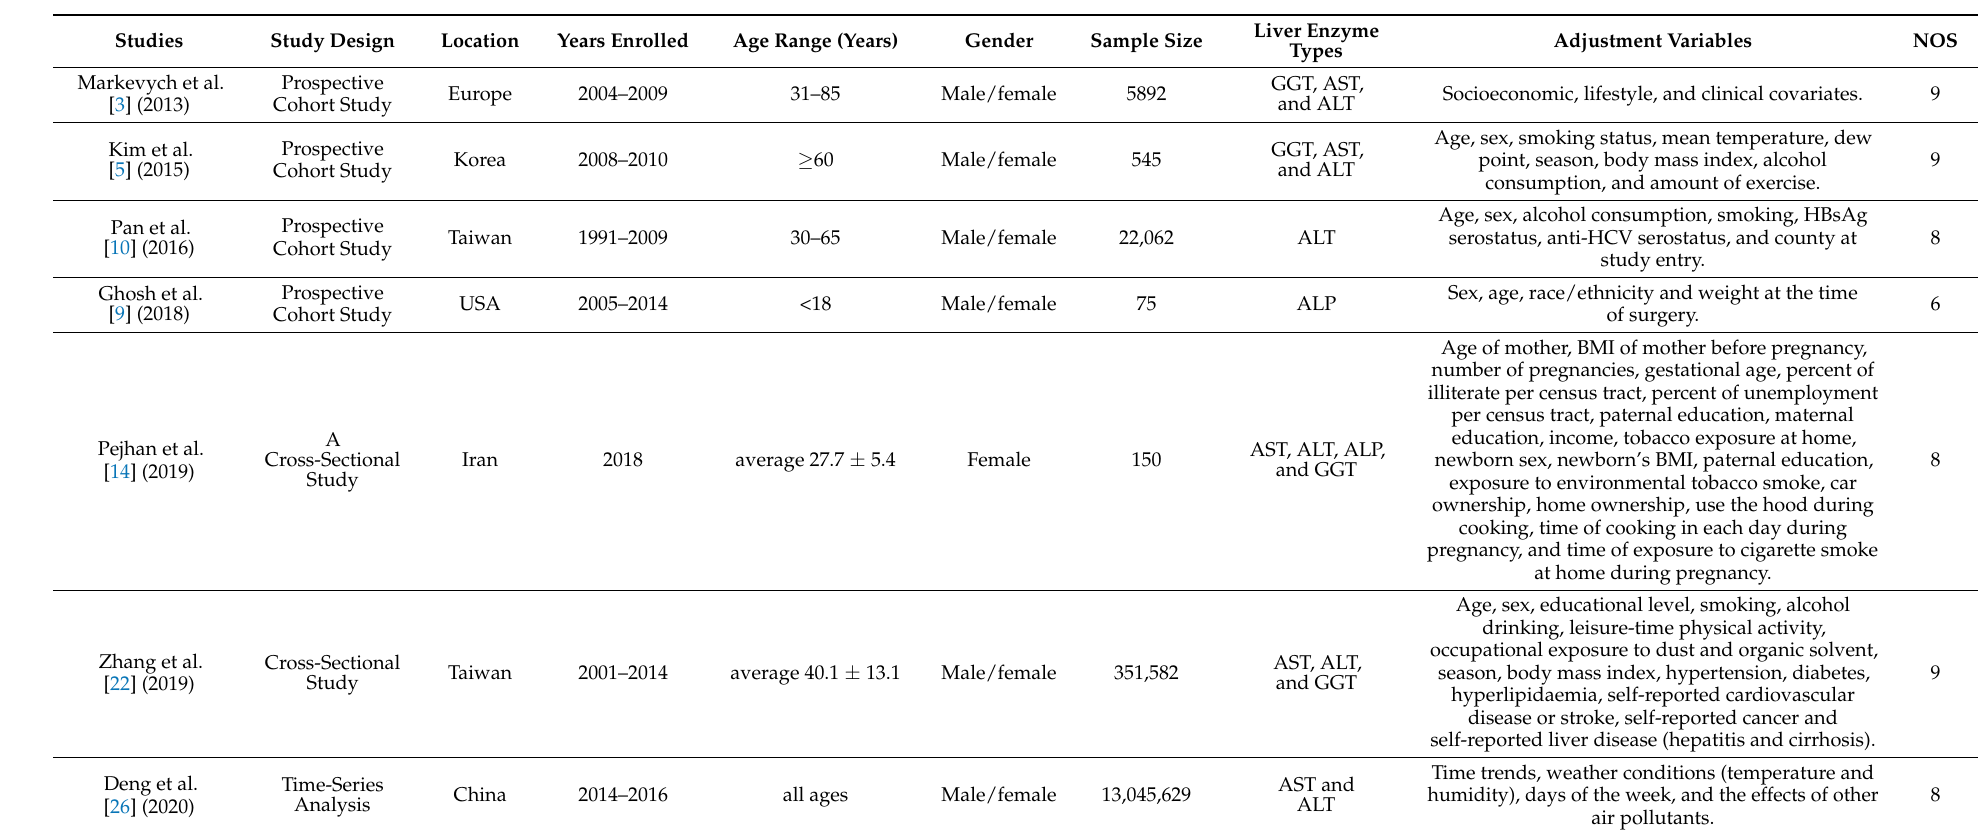
Table 1. General characteristics of the included